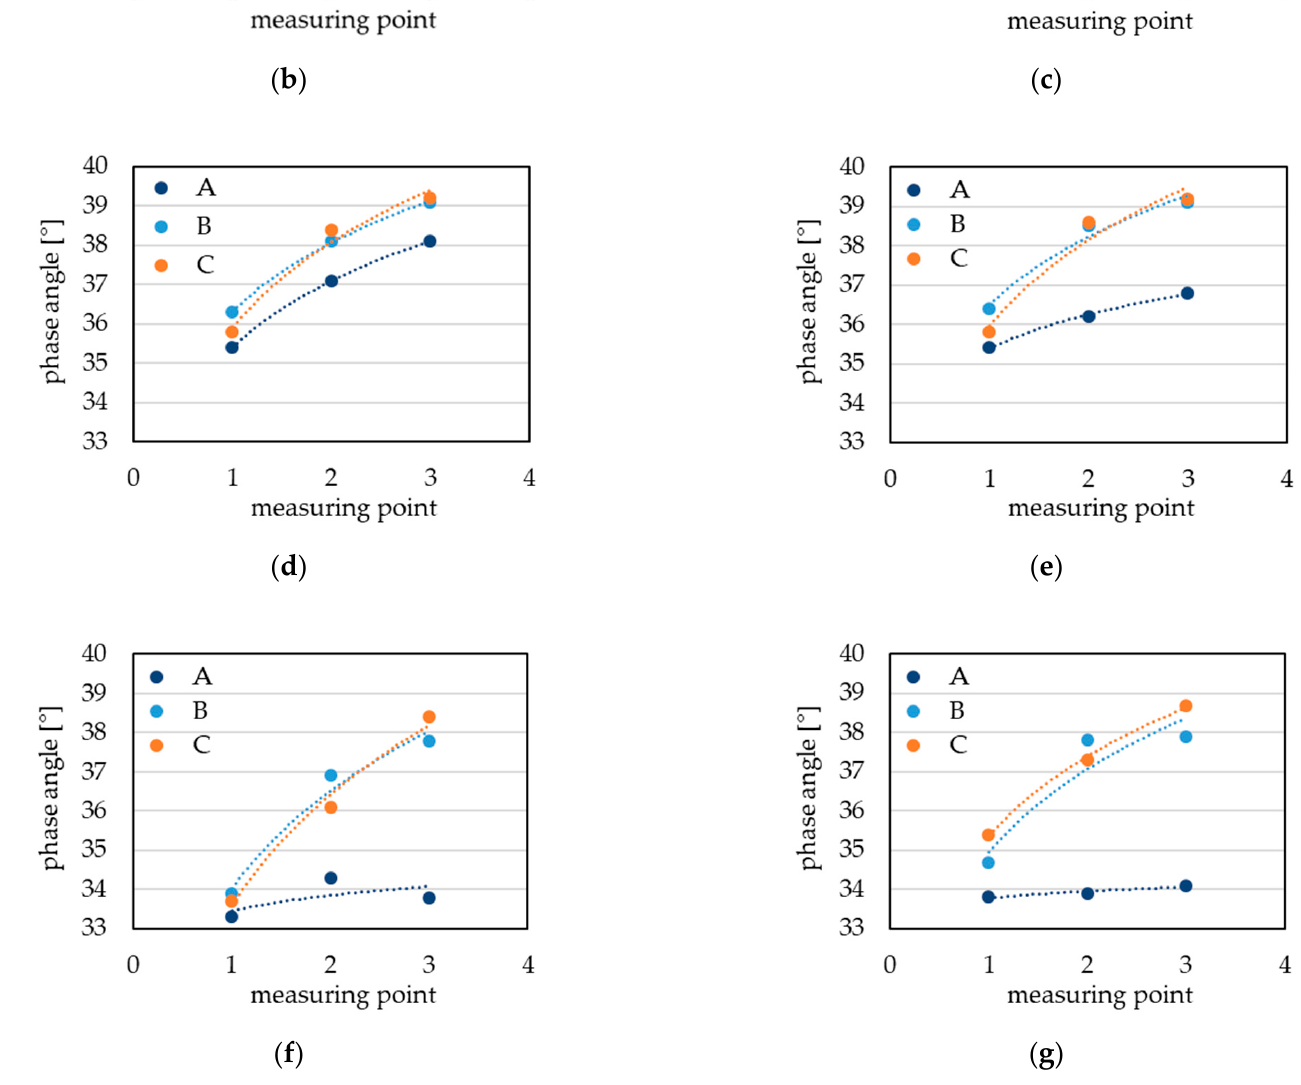
Figure 5. Phase angle measurements for different measuring points of turbine blades: as received state ( a ) after operation time of 303 h ( b – d ) and 473 h ( e – g